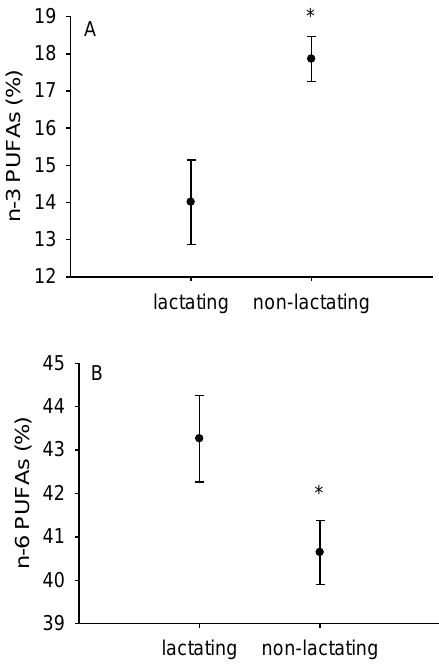
Figure 2. Content of n -3 ( A ) and n -6 ( B ) polyunsaturated fatty acids in isolated liver mitochondria from lactating ( n = 12) and non-lactating ( n = 10) mice. Data are means ± SEM; * p < 0.05, in comparison to lactating mice (F 1,6 = 66.04; p = 0.0002). Table 2. Fatty acid composition of phospholipids in liver and heart mitochondria of lactating (L) and non-lactating control females (C). Values are given in weight %, means ± SEM.